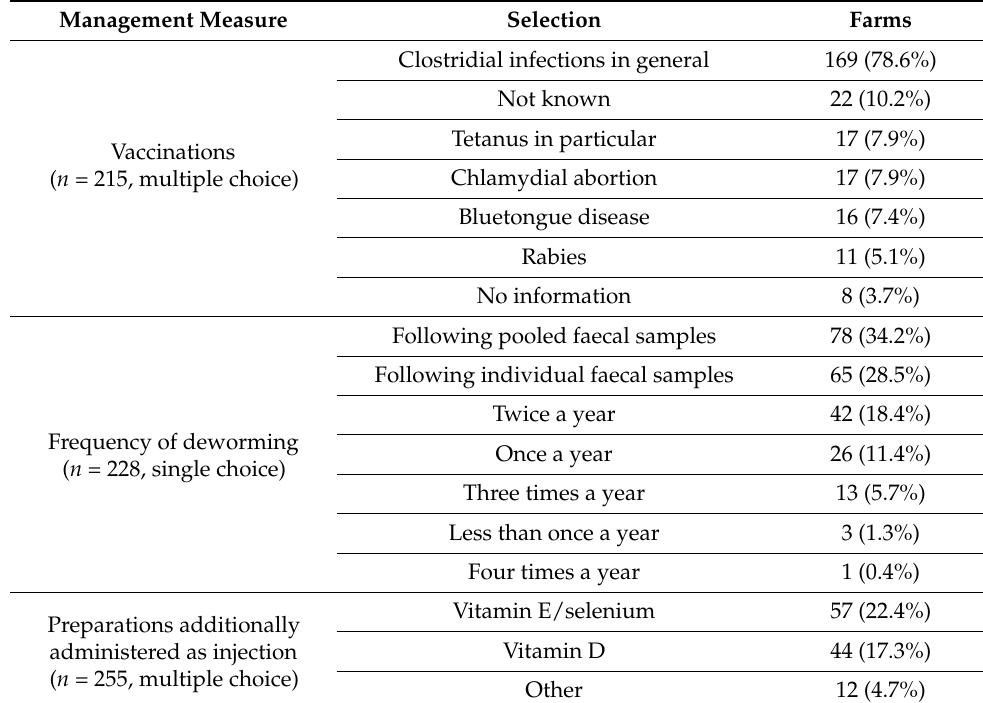
Table 5. Management measures performed in the